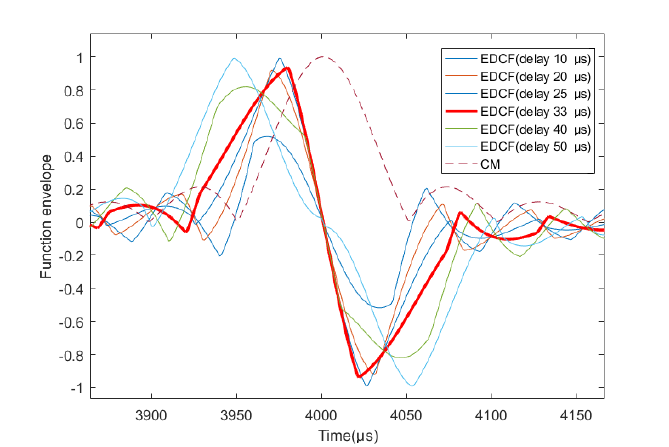
Figure 4. Differential correlation results when τ z ≤ 50 µ